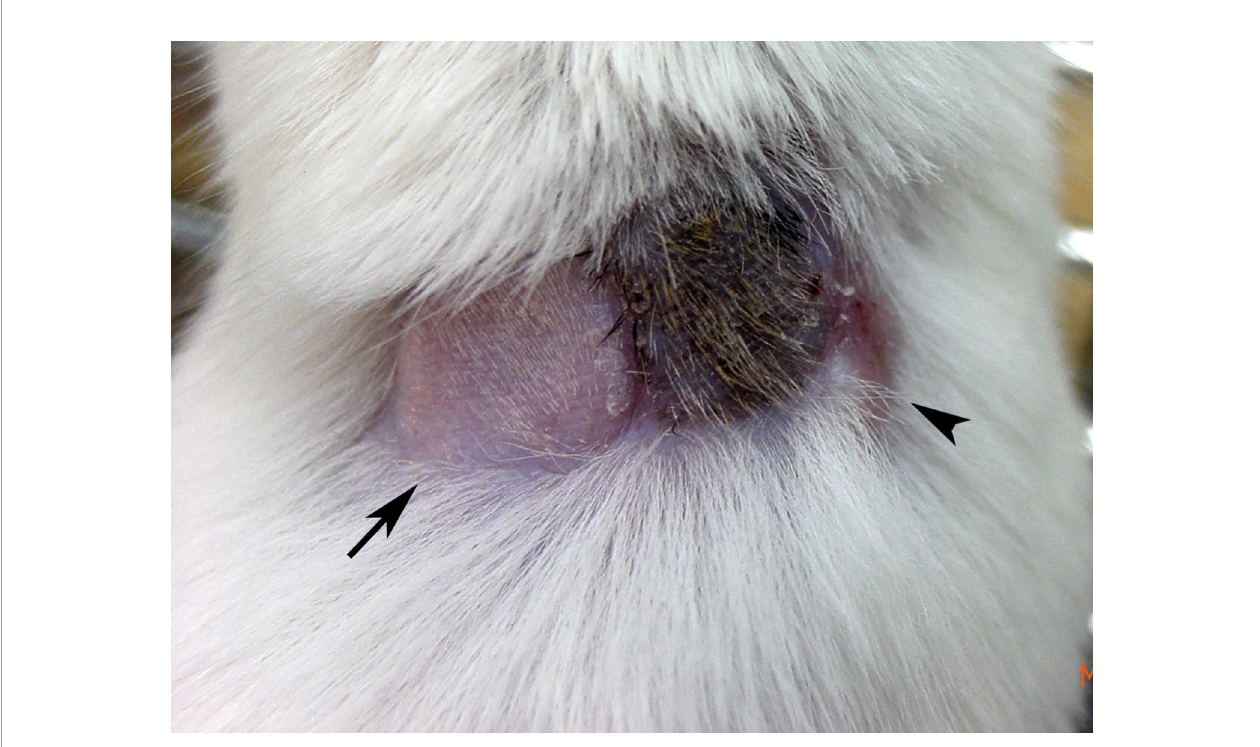
FIGURE 1 | Skin graft tolerance in a state of hematopoietic chimerism. Following in utero injection of C57BL/6 (H-2 b ) BMCs into gestational day 14 FVB/N (H-2 q ) fetuses, skin transplantation was performed in a representative mixed chimera with 5.63% peripheral blood cell chimerism at 1 month old. The image taken at 5 months old showed that syngeneic FVB/N (arrow) and donor C57BL/6 (black hair) skin grafts were well accepted with good hair growth, but third-party C3H (H-2 k , arrowhead) skin had been rejected with a scar. It supported a state of donor-speci fi c immune